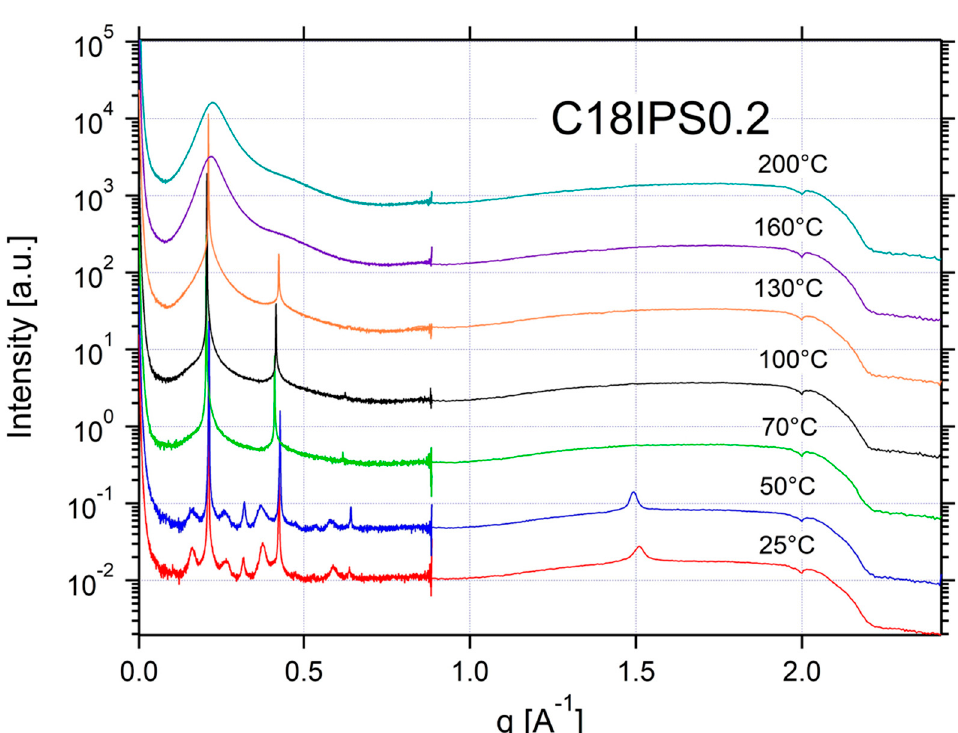
Figure A24. SAXS and WAXS data for 0.2:1 C18IPS:C18LiTFSI.